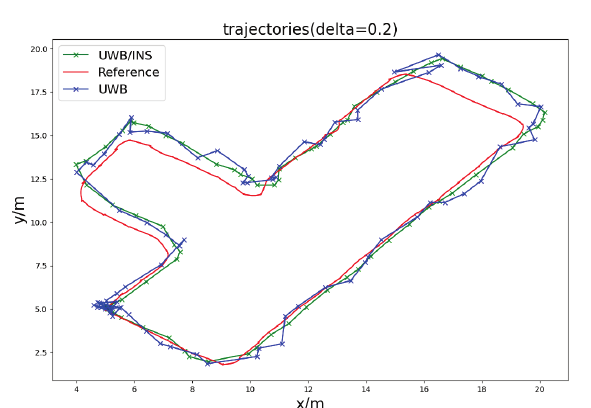
Figure 10 . Comparison of reference trajectory, UWB trajectory, and UWB/INS integration trajectory when ( are the diagonal elements of the observation noise covariance matrix).